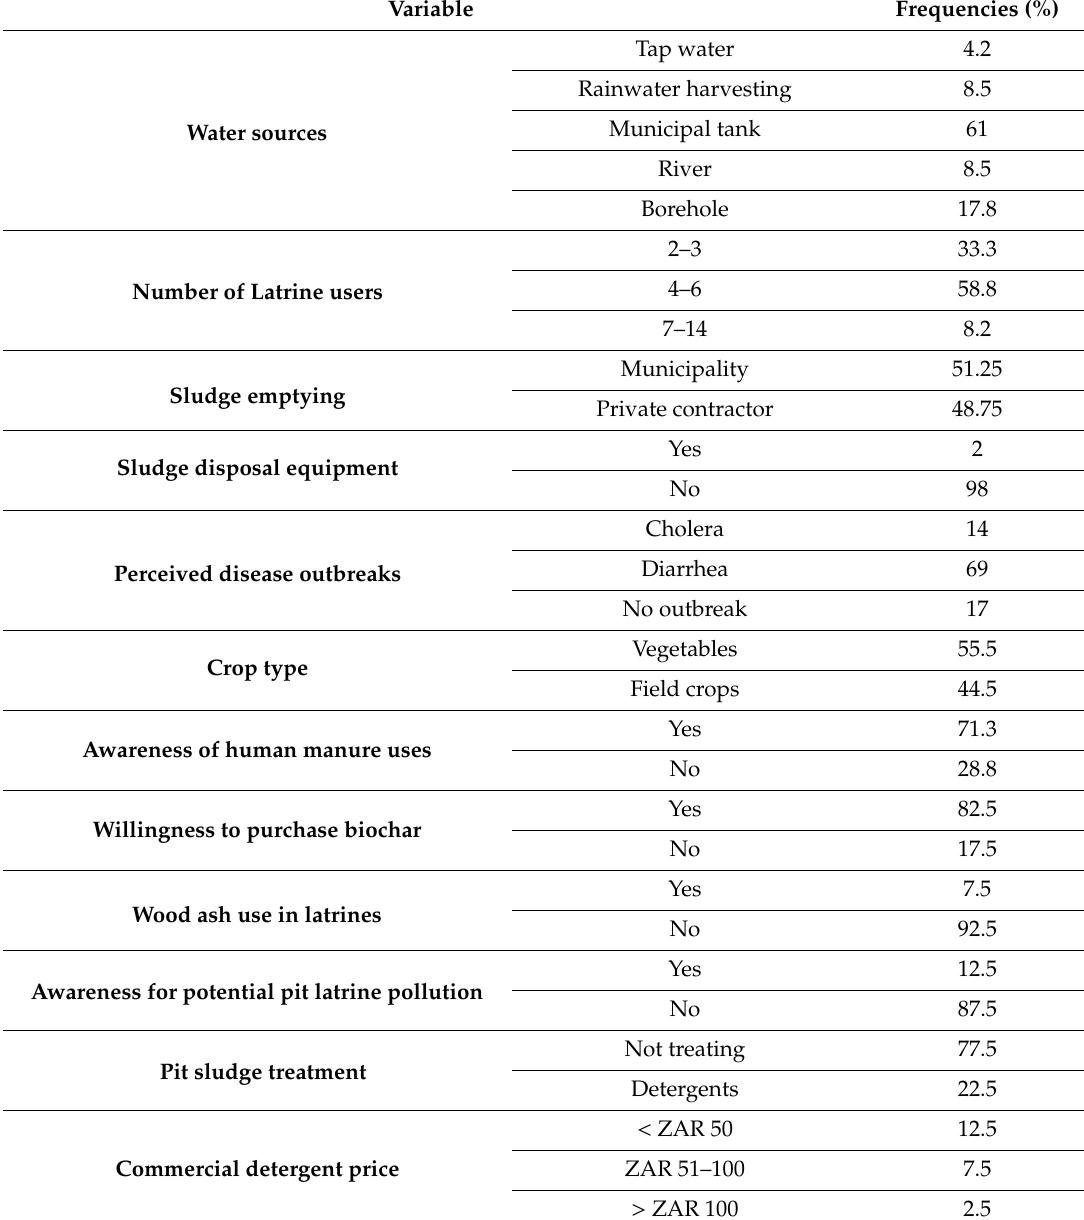
Table 4. Frequencies of the significant variables on the water and sanitation in Monontsha